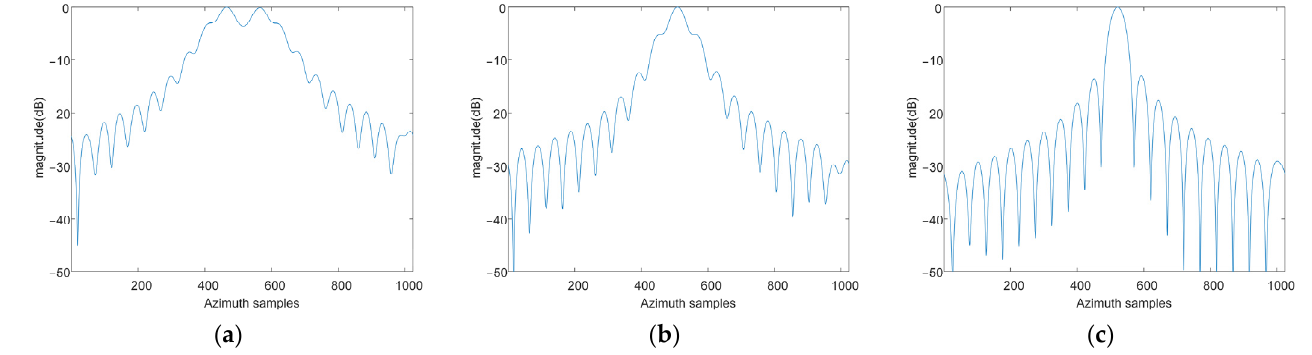
Figure 17. Azimuth pro fi les of target P1 processed by di ff erent algorithms. ( a ) The conventional method; ( b ) The reference method; and ( c ) The proposed method.